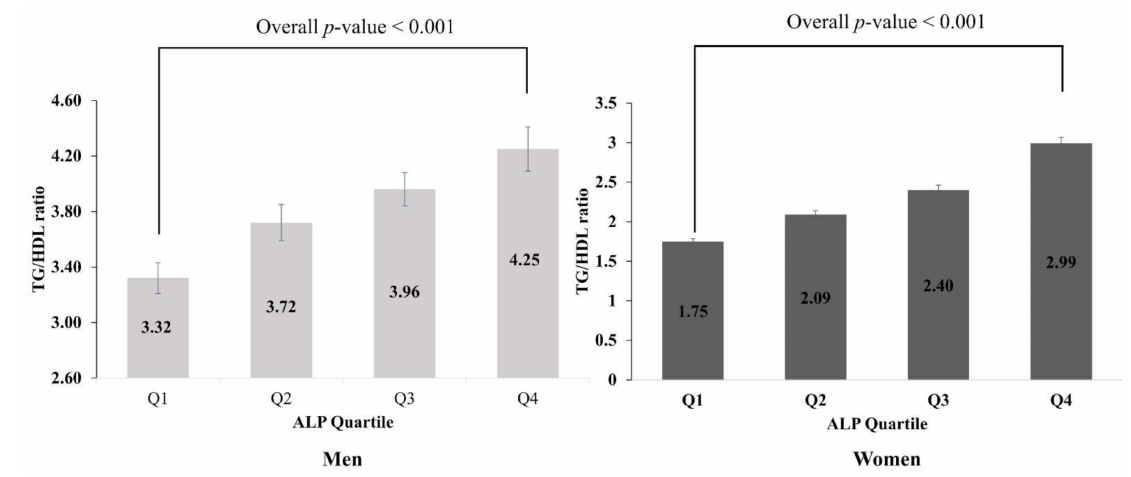
Figure 2. Trend analysis of TG/HDL ratio according to ALP quartile in both sexes. Values are assessed by